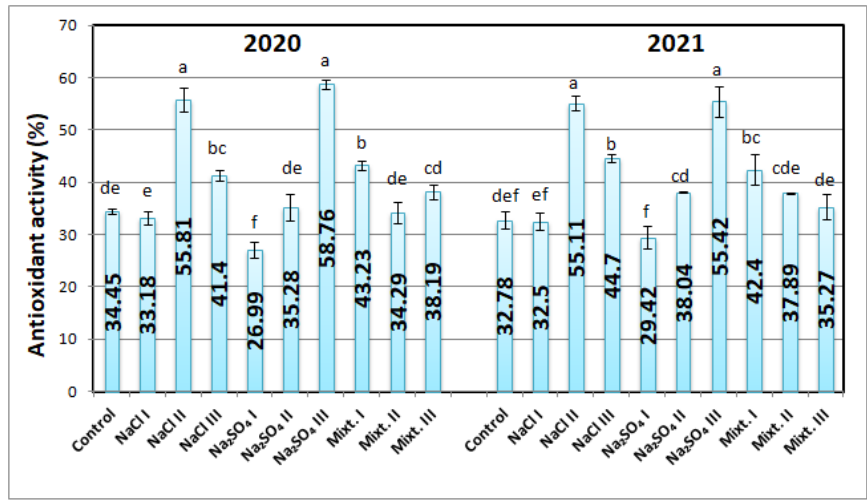
Figure 9. Antioxidant activity of N. cataria L. studied variants with significant differences at 0.001 level indicated with letters.